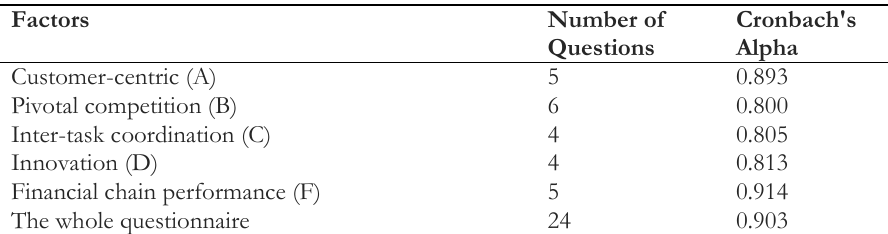
Table 3. Evaluation of the reliability of the